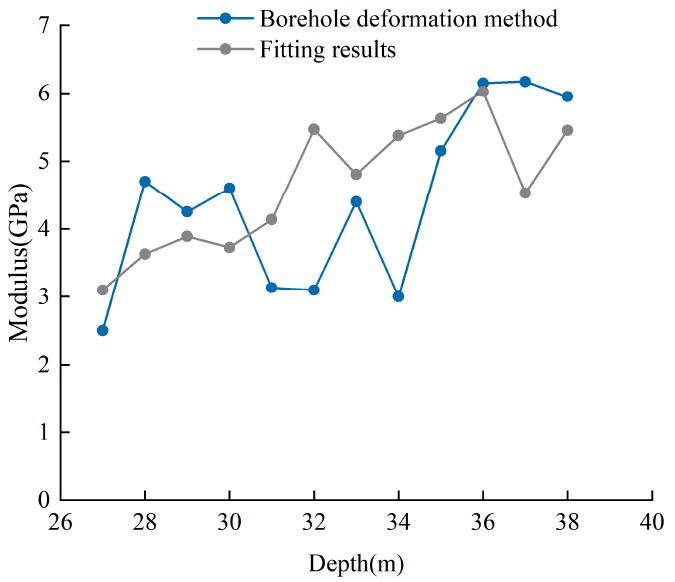
Figure 10. Comparison of fi tt ing results and borehole deformation method.